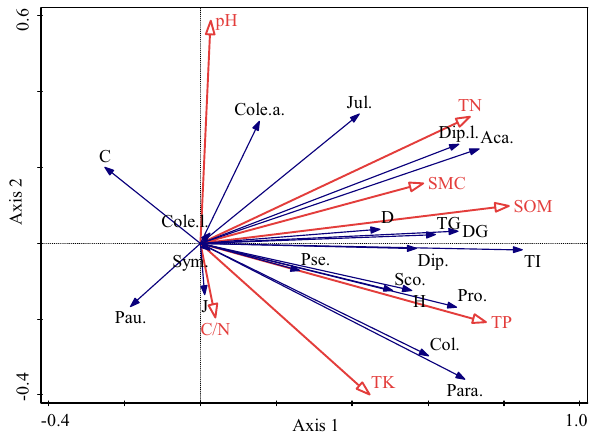
Figure 2. Results of redundancy analysis of soil fauna groups and diversity characteristics in association with soil properties. Hollow arrow points represent soil properties labeled as: soil moisture content (SMC), pH, soil organic matter (SOM), total nitrogen (TN), total phosphorus (TP), total potassium (TK) and ratio of carbon to nitrogen (C/N). Solid arrow points represent groups and diversity characteristics of soil fauna labeled as: Aca., Acariformes; Para., Parasiformes; Col., Collembola; Dip., Diptera; Sym., Symphyla; Dip.l., Diplura larvae; Cole.l., Coleoptera larvae; Cole.a., Coleoptera adult; Pse., Pseudoscorpiones; Sco., Scolopendromorpha; Pro., Protura;